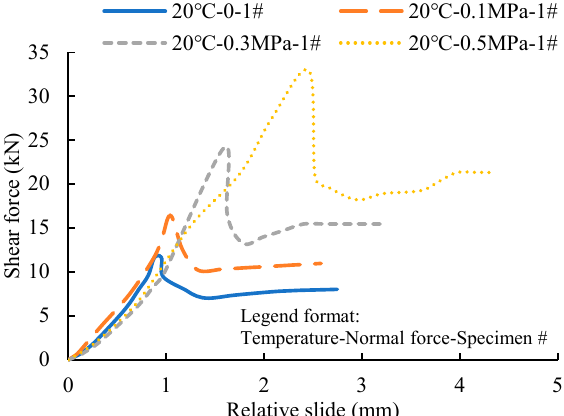
Figure 10. Shear force-relative slide relationship without separator layer.